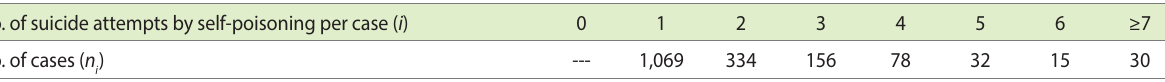
Table 1. Observed frequencies of suicide attempts by self-poisoning in western Iran, 2015 No. of suicide attempts by self-poisoning per case ( i )